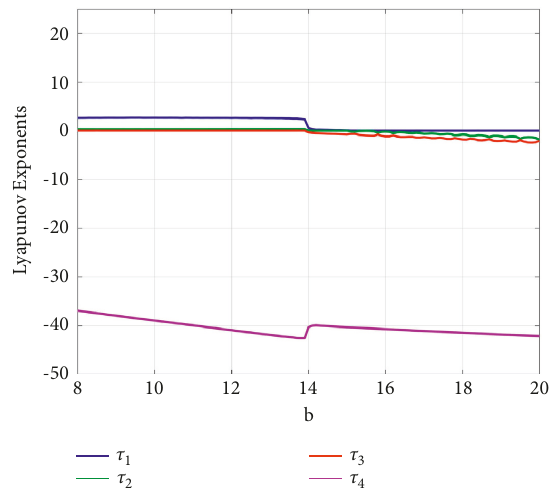
Figure 9: Lyapunov exponents for the model (1) when b varies in [ 8 , 20 ] and ( a, c,d ) � ( 25 , 90 , 6 ) .